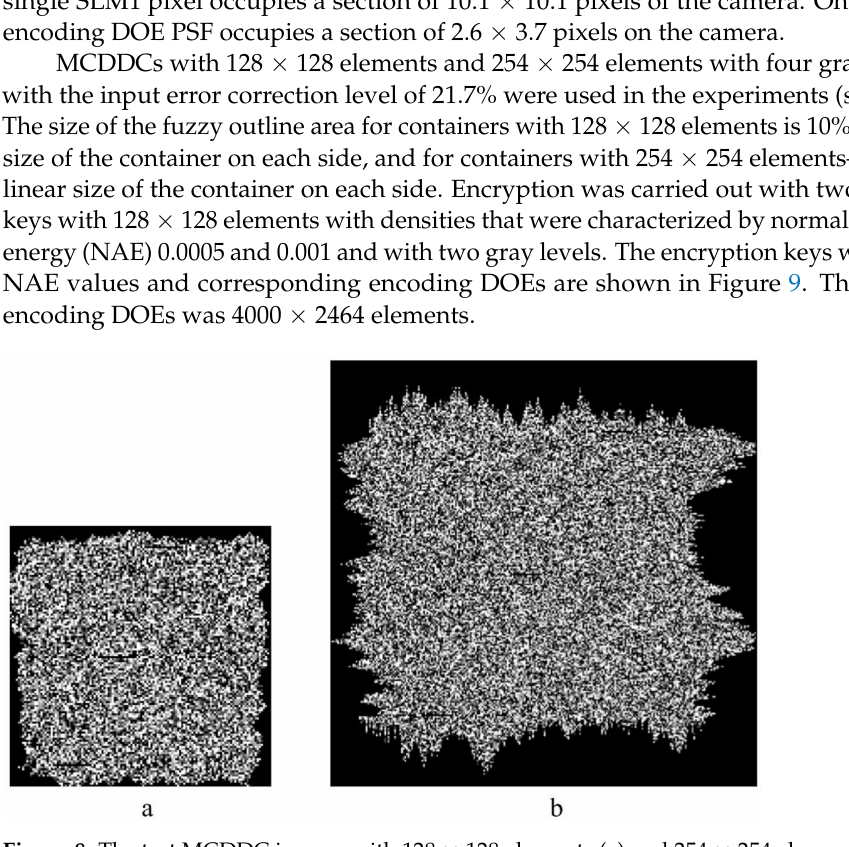
Figure 8. The test MCDDC images with 128 × 128 elements ( a ) and 254 × 254 elements ( b